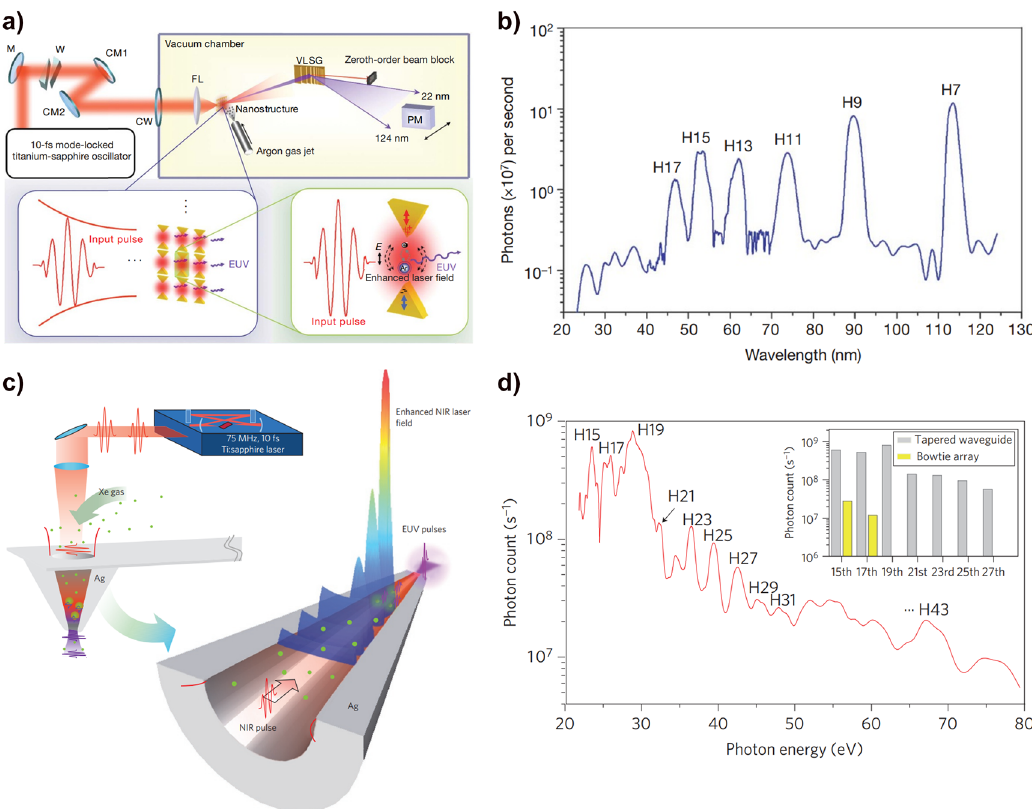
Figure 8: Plasmonically enhanced HHG in gases. (a) Schematic of experimental setup and mechanism of plasmonically enhanced HHG in an Au bowtie nanostructure array surrounded with Ar gas. The enhanced laser field by SPR from the bowtie nanostructure enables HHG. Ar, argon atom; CM, chirped mirror; CW, chamber window; FL, focusing lens; M, mirror; PM, photon multiplier; VLSG, varied-line-spacing grating; W, wedge plate; E, electric field [12]. (b) High harmonic spectrum from an Au bowtie nanostructure array surrounded with Ar gas. (c) Schematic of SP enhanced HHG in a 3D metallic waveguide fi lled with Xe gas. (d) High harmonic spectrum from the 3D metallic waveguide fi lled with Xe gas. The inset shows the comparison between the high harmonic photon yield of the 3D metallic waveguide fi lled with Xe gas (gray) and the Au bowtie structure array surrounded with Ar gas (yellow)